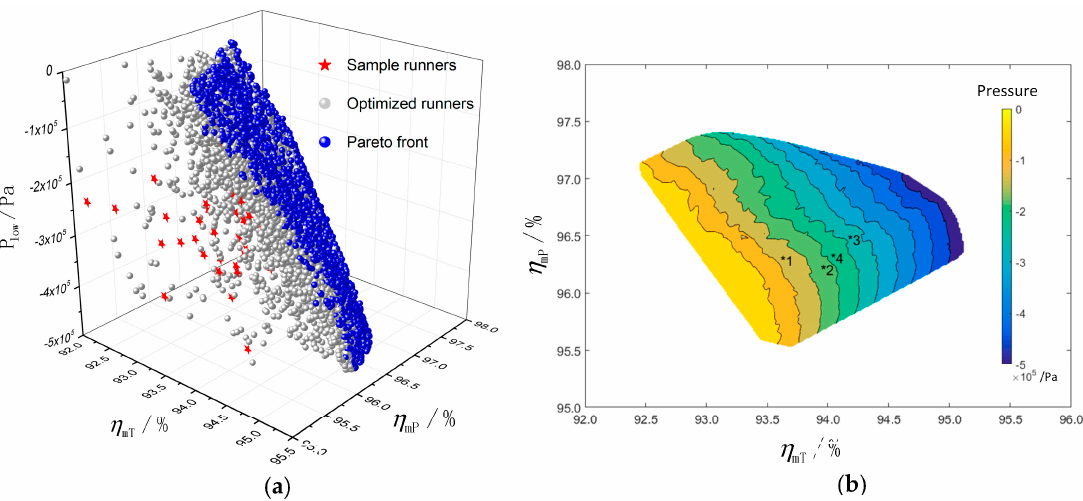
Figure 6. Optimization results. ( a ) Optimized runners; and ( b ) Pareto front surface.